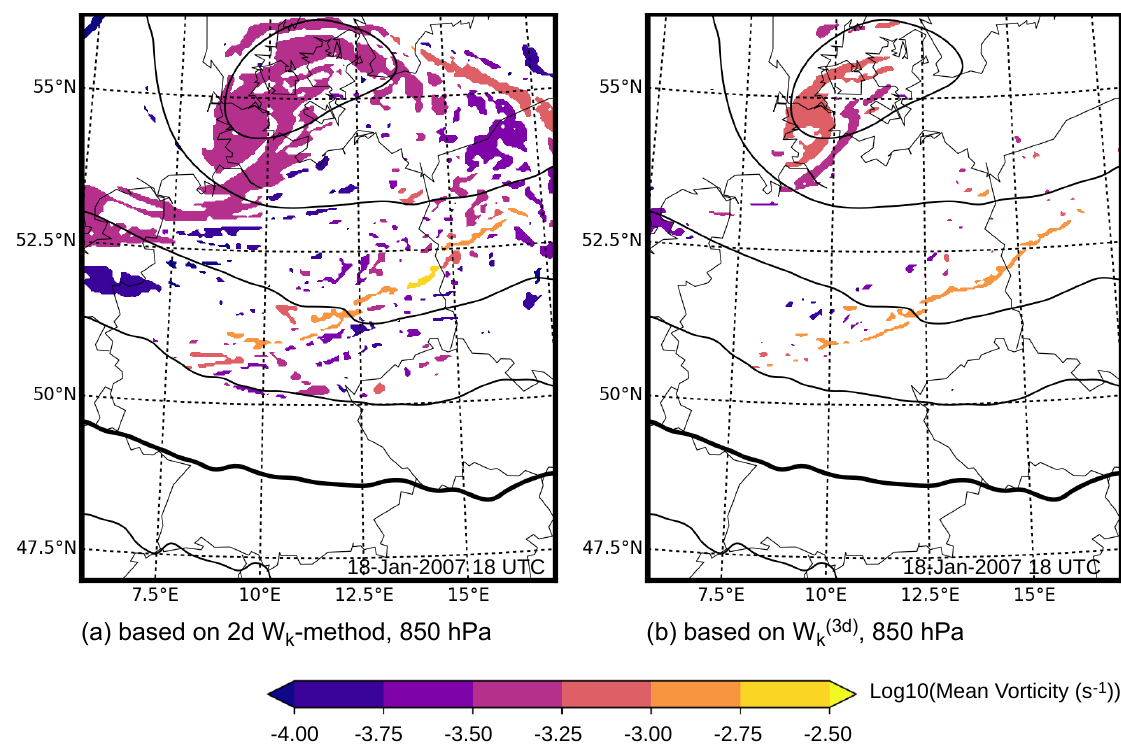
Figure 15. Vortex patches fields ( a ) derived by the two-dimensional W k -method and ( b ) derived by the ( 3 d ) three-dimensional W -method, in the COSMO simulation on 18 January 2007 18:00UTC color shaded by k the logarithm of the mean vorticity (1/s) at 850hPa. Black contours are the geopotential height in 80-m intervals; the thick black line corresponds to a geopotential height of